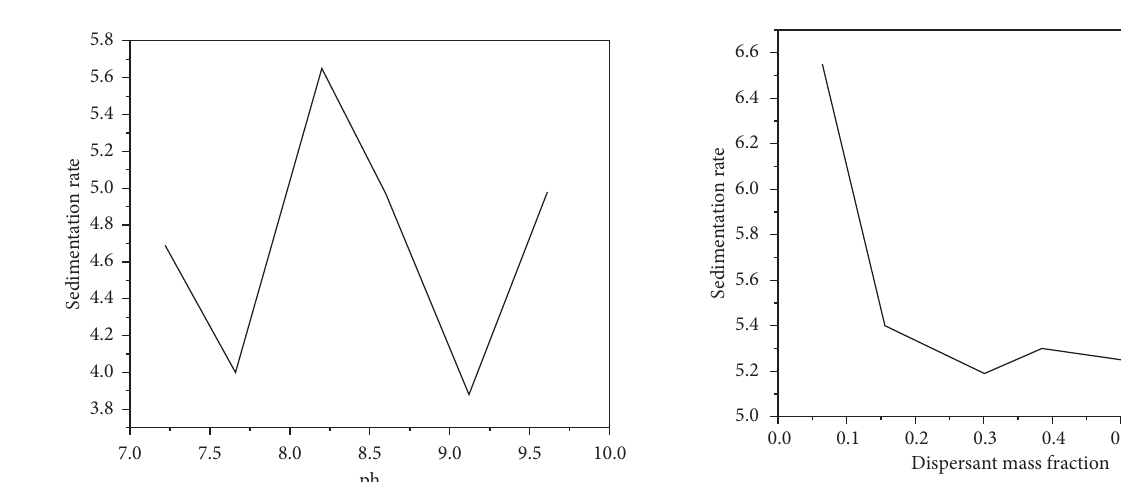
Figure 2: Relationship between sedimentation rate and pH value.